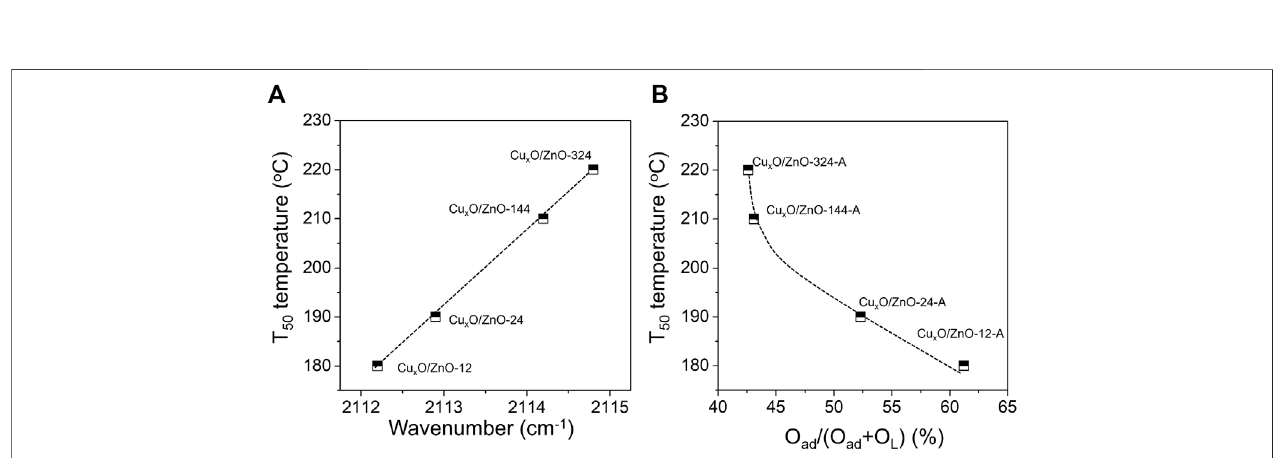
FIGURE 11 | (A) Dependence of the T concentration.